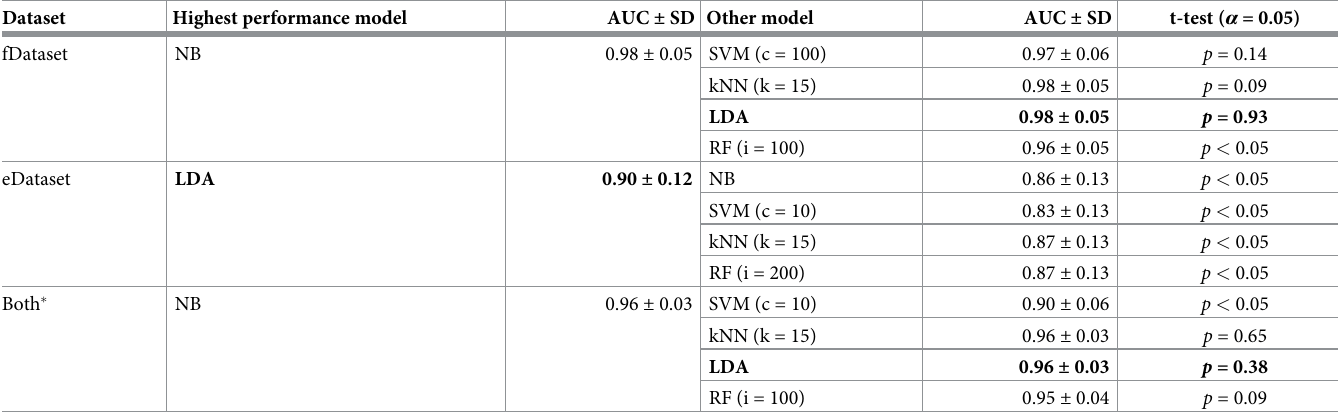
Table 3. Summary of the statistical comparison based on the AUC performance of the best classifiers per dataset.